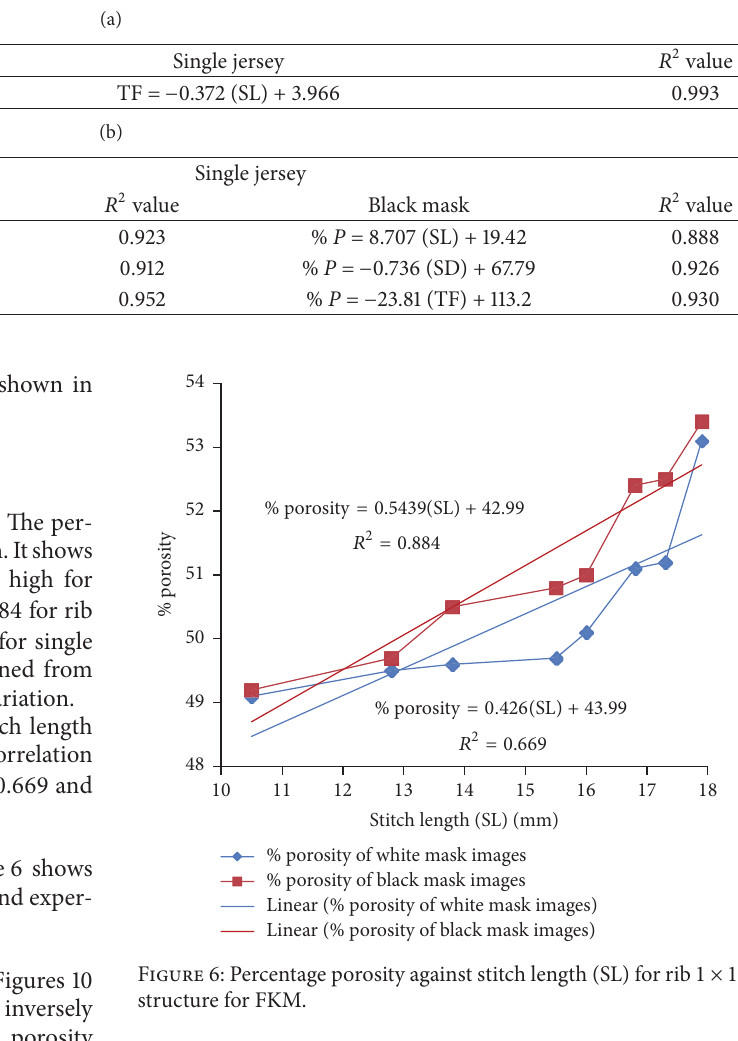
Table 7: Linear regression equations—for the different features for the CKM knits.